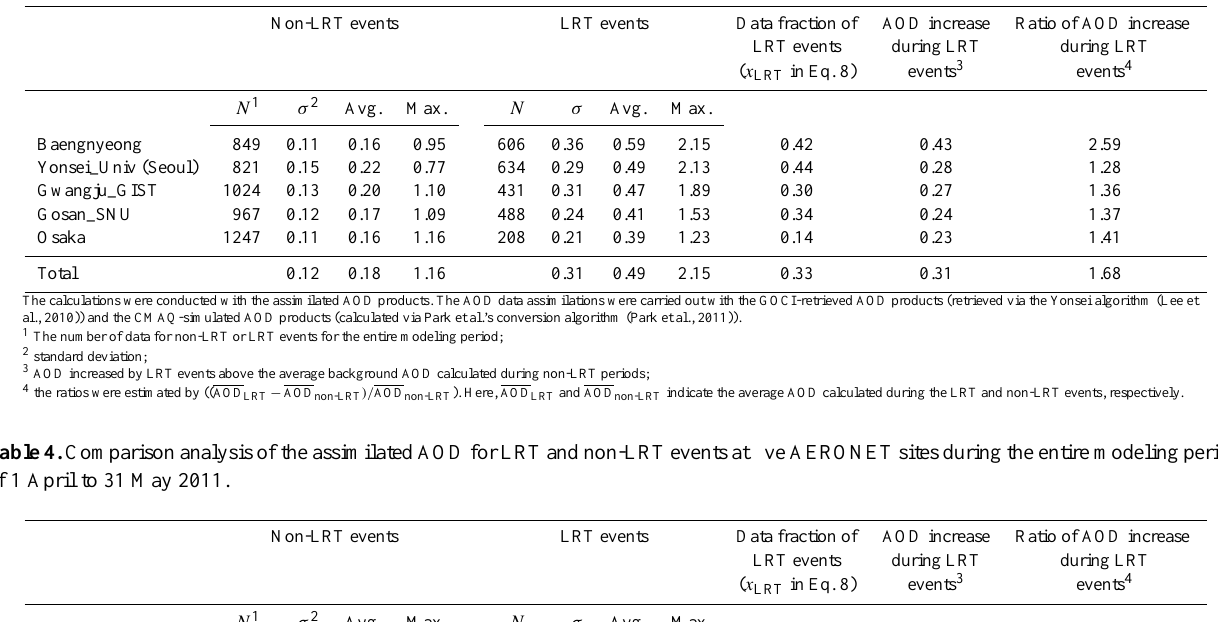
Table 3. Comparison analysis of the assimilated AOD for LRT and non-LRT events at five AERONET sites during the entire modeling period of 1 April to 31 May 2011. Non-LRT events LRT events Data fraction of AOD increase Ratio of AOD increase LRT events during LRT during LRT ( x LRT in Eq. 8) events 3 events 4